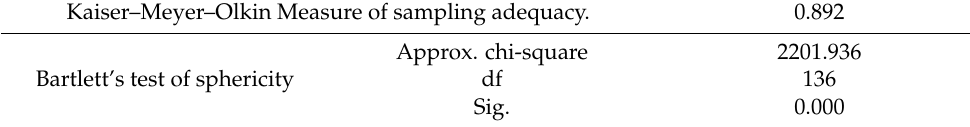
Table 3. KMO and Bartlett